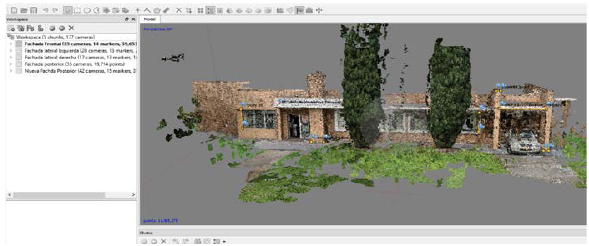
Figure 7: Processing of the exterior point